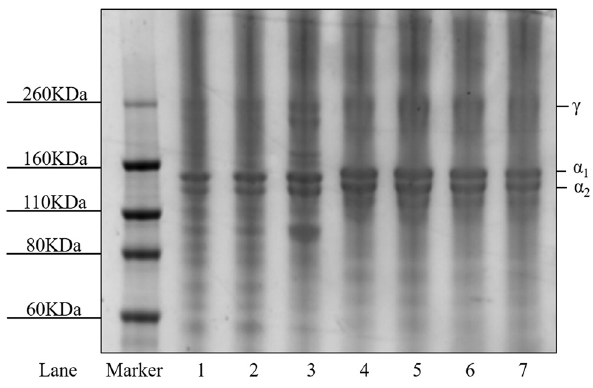
Figure 3: SDS - PAGE of the gelatin samples. Lane 1: sample EB - 1; lane 2: sample EB - 2; lane 3: sample EB - 3; lane 4: sample LB - 1; lane 5: sample LB - 2; lane 6: sample LB - 3; and lane 7: sample LB - 4. and hydroxyproline residues facilitate intra - and intermole - cular crosslinking in gelatin solution, thus stabilizing the triple helical structure and improving thermostability. The stable structure of the enzymatic gelatin samples was also con fi rmed by the circular dichroism spectra. Excellent ther - mostability is desirable for gelatin in some applications. For example, it helps maintain the gel state within a certain temperature range, leading to a better mouth feel [ 22 ] and easier processing.